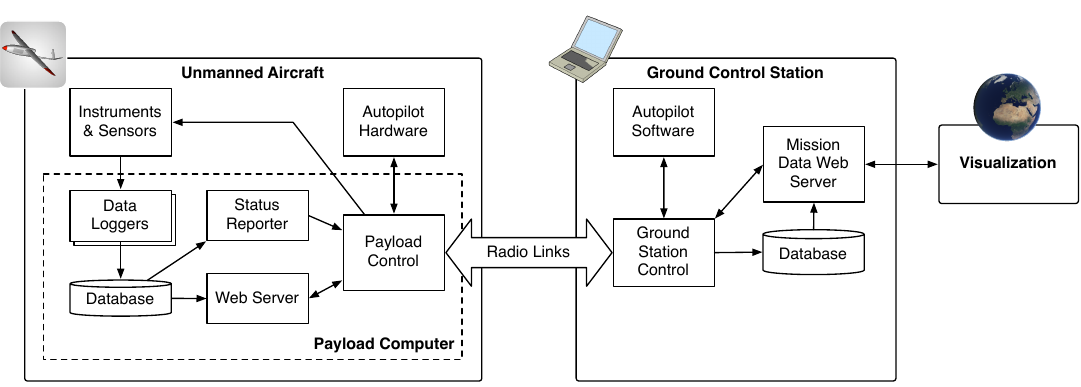
that handles merging and reprojection of elevation and raster data layers has also been developed as part of the visualization system. Figure 3: The level of detail (LOD) pyramid. Higher LODs cover the same area, but at in- creasingly higher resolutions.